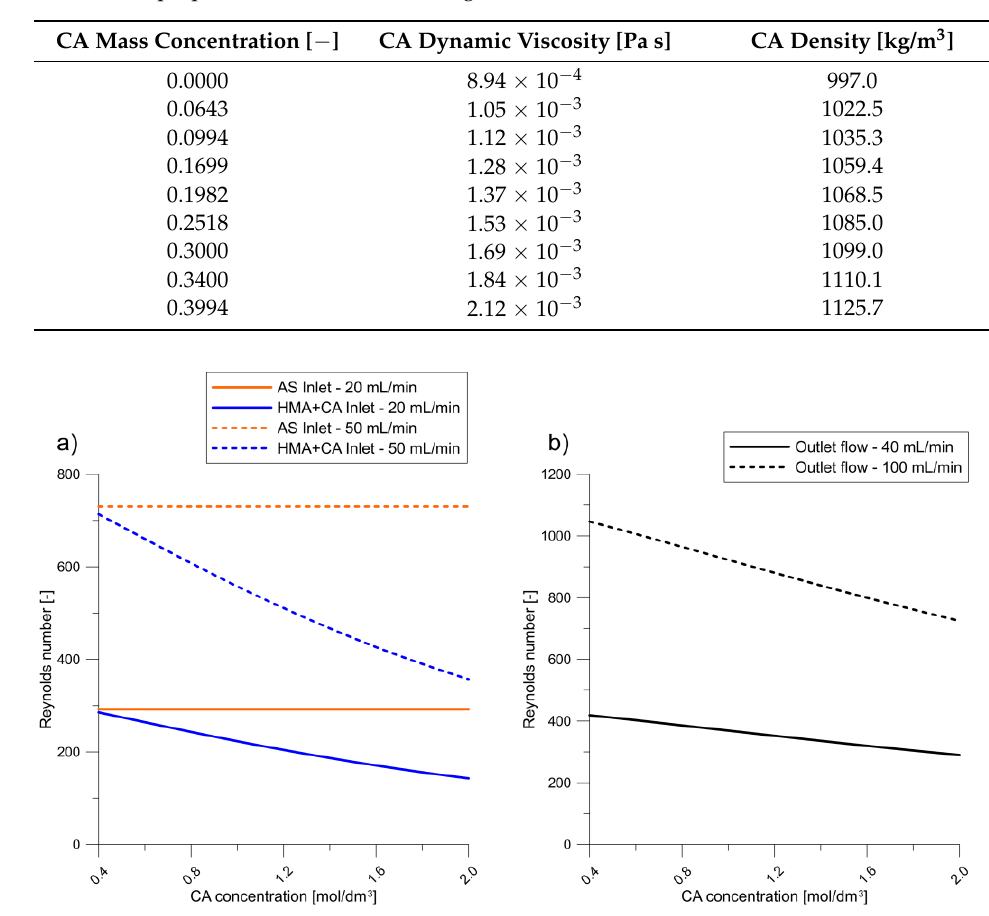
Table 3. CA properties at 298.15 K according to Ref. [31].